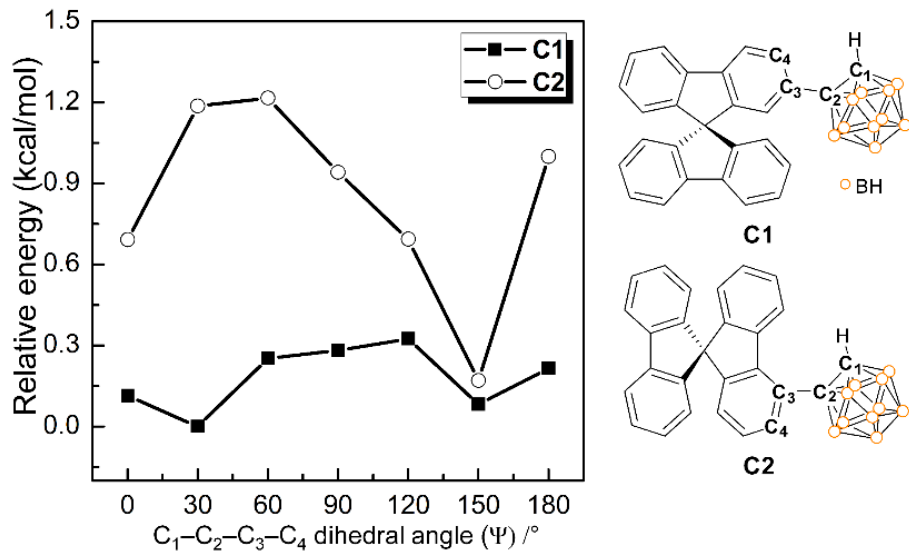
Figure 5. Relative energy diagrams ( ∆ E / kcal · mol − 1 ) for C1 and C2 : relative energy as a function of dihedral angle in each ground (S 0 ) state.